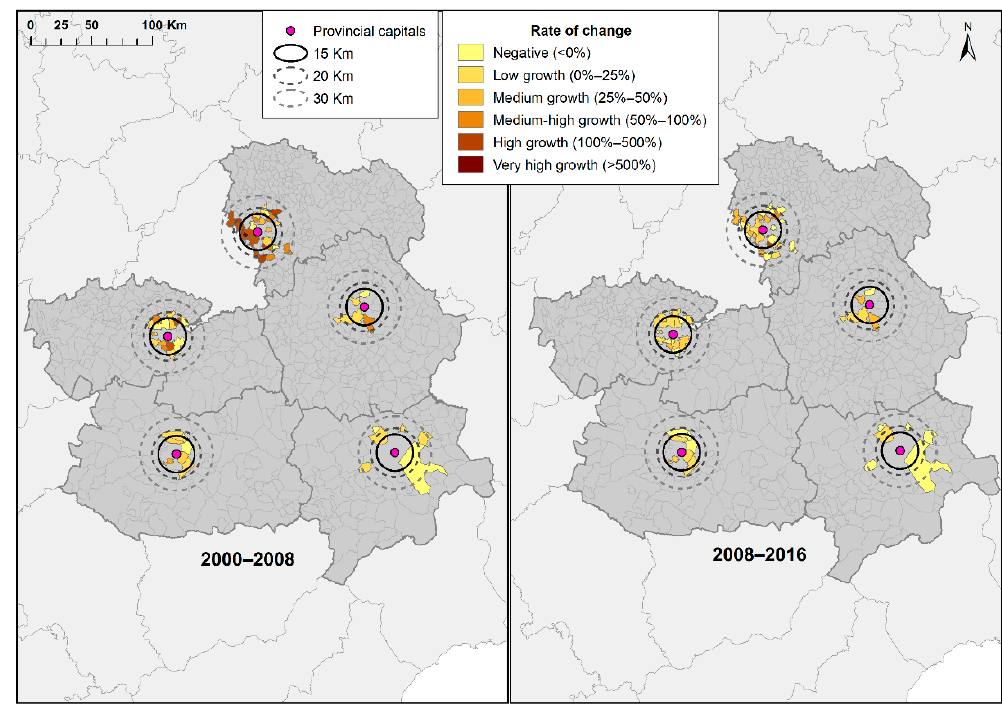
Figure 8. Rate of change in population 2000–2008 and 2008–2016.